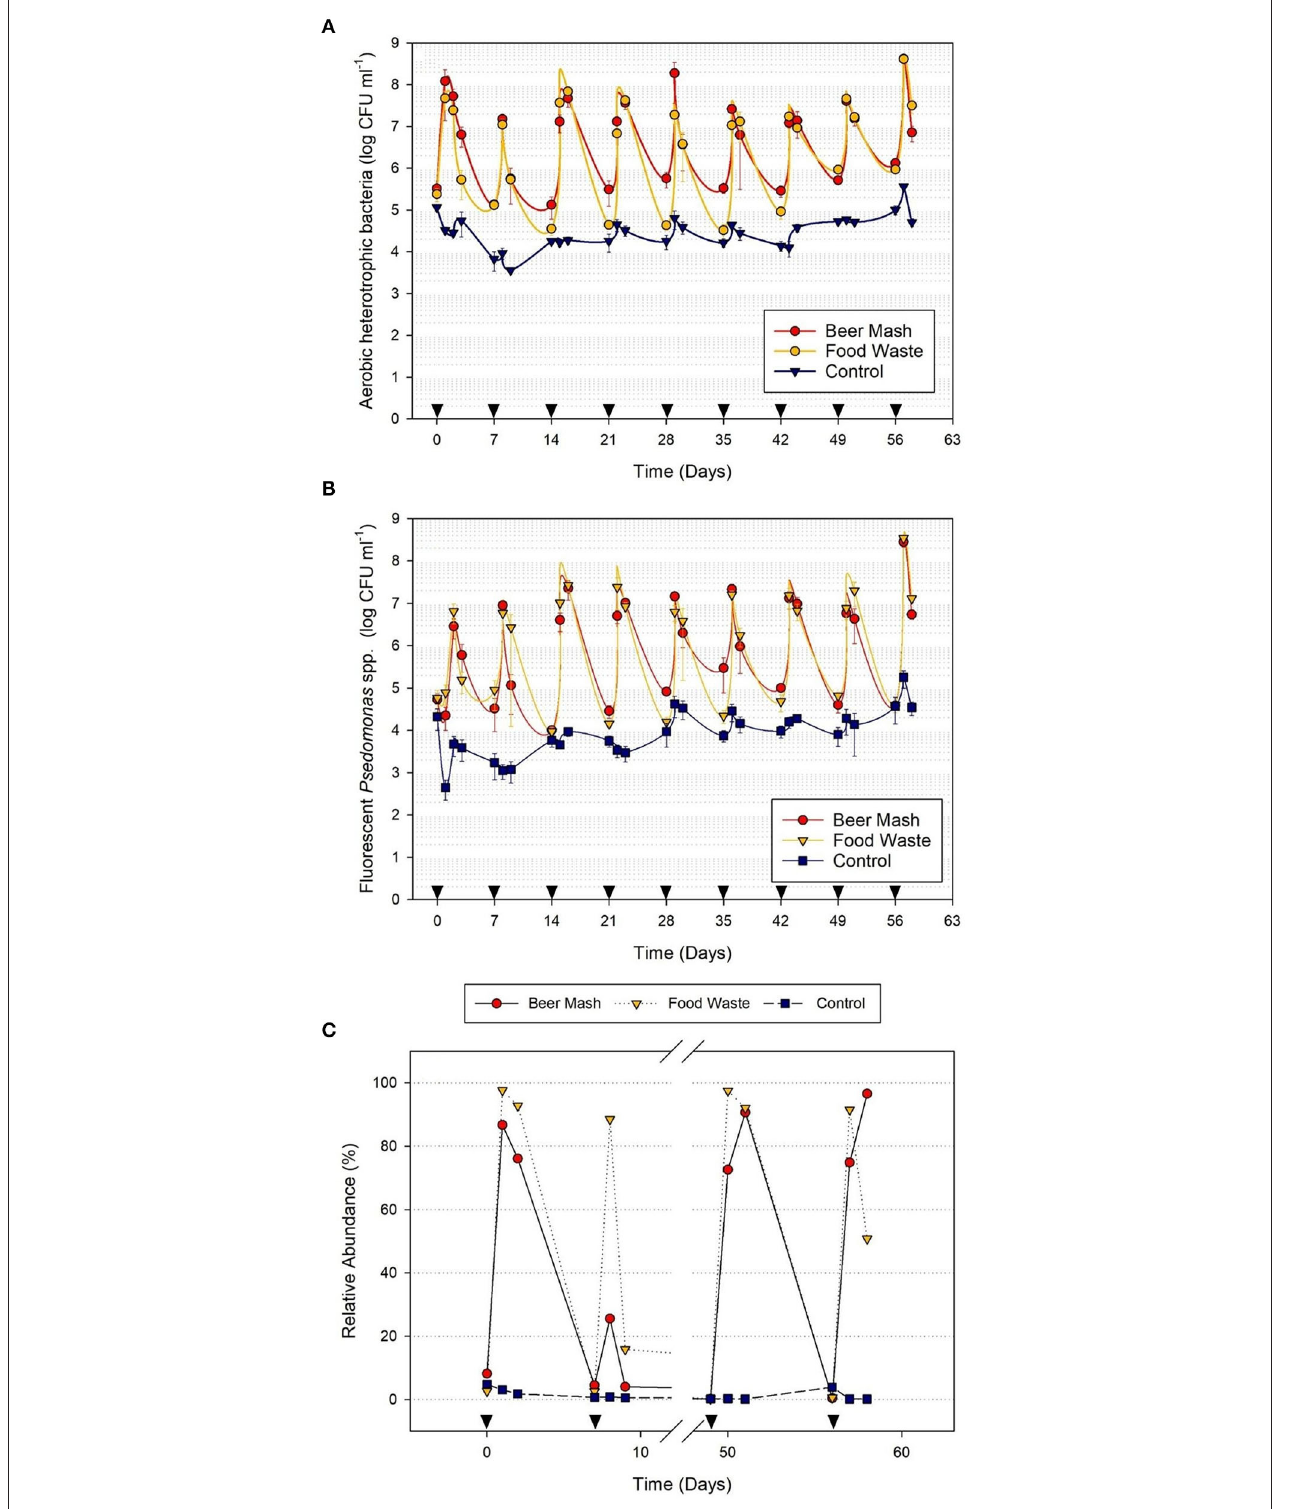
FIGURE 2 | Population dynamics of (A) aerobic heterotrophic bacteria and (B) fluorescent pseudomonads in the nutrient solution as detected by selective media in a greenhouse experiment with citrus as the host plant. Treatments consisted of nutrient solution amended and not amended (control) with beer mash BM and food waste FW digestate every week for 9 weeks. (C) Relative abundance of fluorescent pseudomonads as detected by NGS analysis of samples taken from 4 weeks out